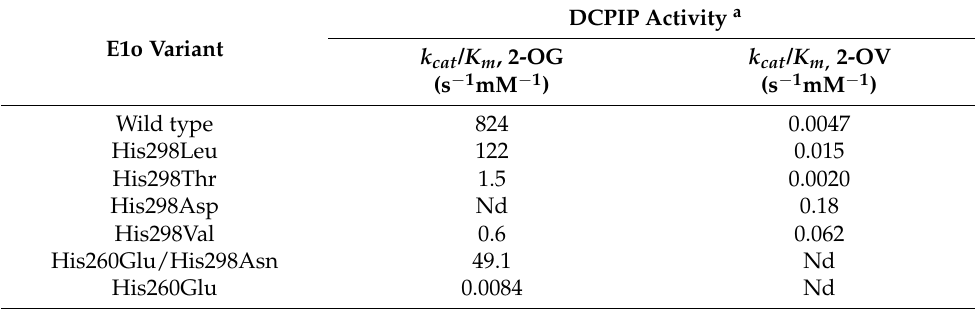
Table 1. Catalytic efficiencies of the E. coli E1o variants towards 2-OG and 2-OV